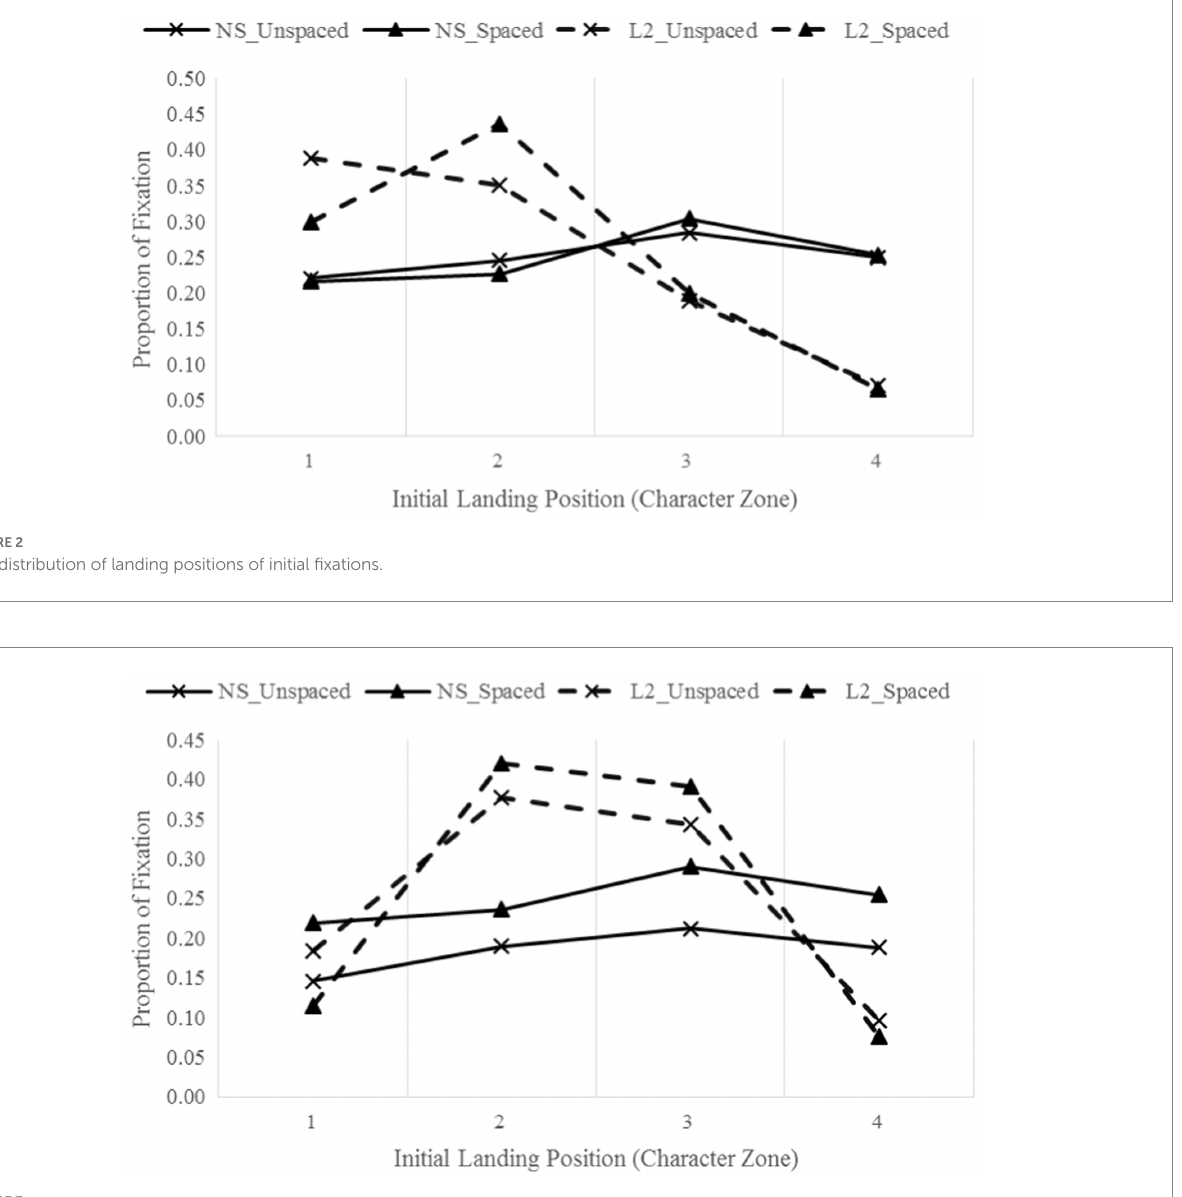
FIGURE 3 The distribution of landing positions in single fixation